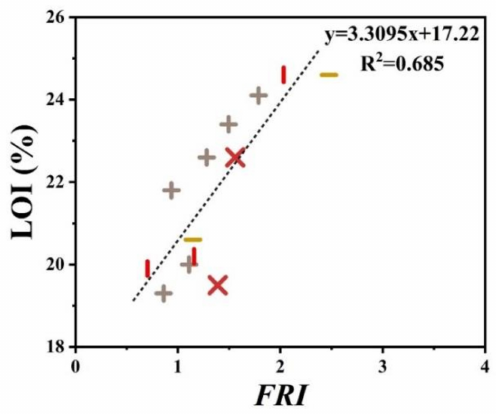
Figure 11. FRI values of PP as a function of LOI test results. Symbols are indicative of di ff erent types of carbon-based flame retardant used.